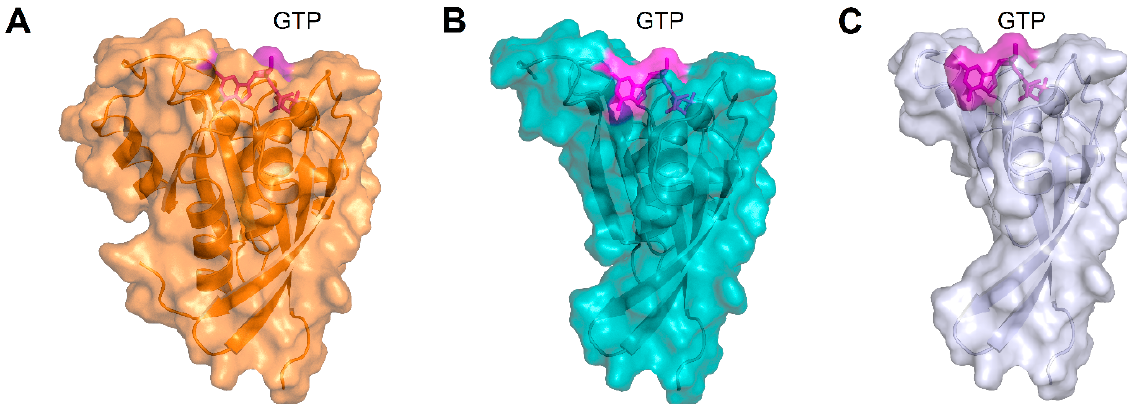
Figure 8. ( A ) Comparison of the three-dimensional structure of ( A ) GTP-bound WT (black), ( B ) GTP-bound T26N (blue), ( C ) G3D-bound WT (red), and ( D ) G3D-bound T26N (green) Rab-28 after 500 ns MD simulations. Protein structure is shown as a ribbon connecting C α atoms, Mg 2+ -ion is represented as a sphere colored with the same color as the protein structure, GTP/G3D are represented as sticks with N atoms in blue, O atoms in red, and P atoms in orange and labeled. The switch 1 region of each state is highlighted with a lighter hue of the protein structure color and labeled.